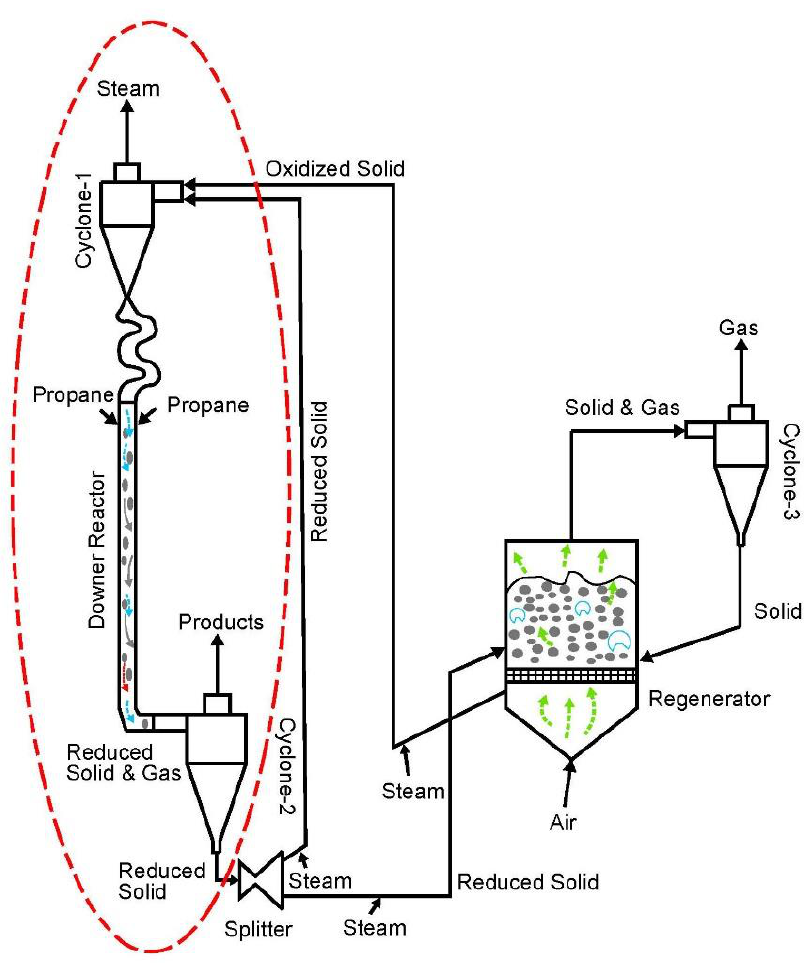
Figure 12. Schematic PODH Process Flow Sheet. The process components inside the red marked section were considered in the CPFD simulations. Adapted with permission from [84]. Copyright 2020, Copyright Owners’: Elsevier.